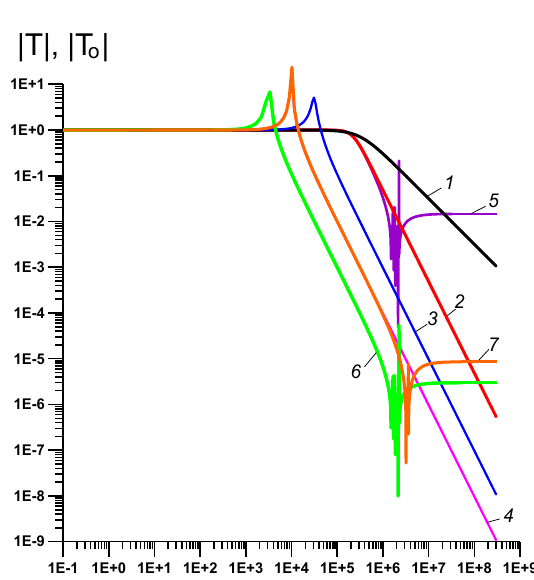
Fig. 6. Transmission coefficients T 0 (without shield, curve 1) and T (2-6) for L= 130  H (1-6) and 13  H (7) at capacitances respectively 1.92 ․ 10 -9 (2, 5), 10 -7 (3), 10 -6 (4), 10 -5 (6) F. Curves 5 and 7 are constructed taking into account the inter-turn